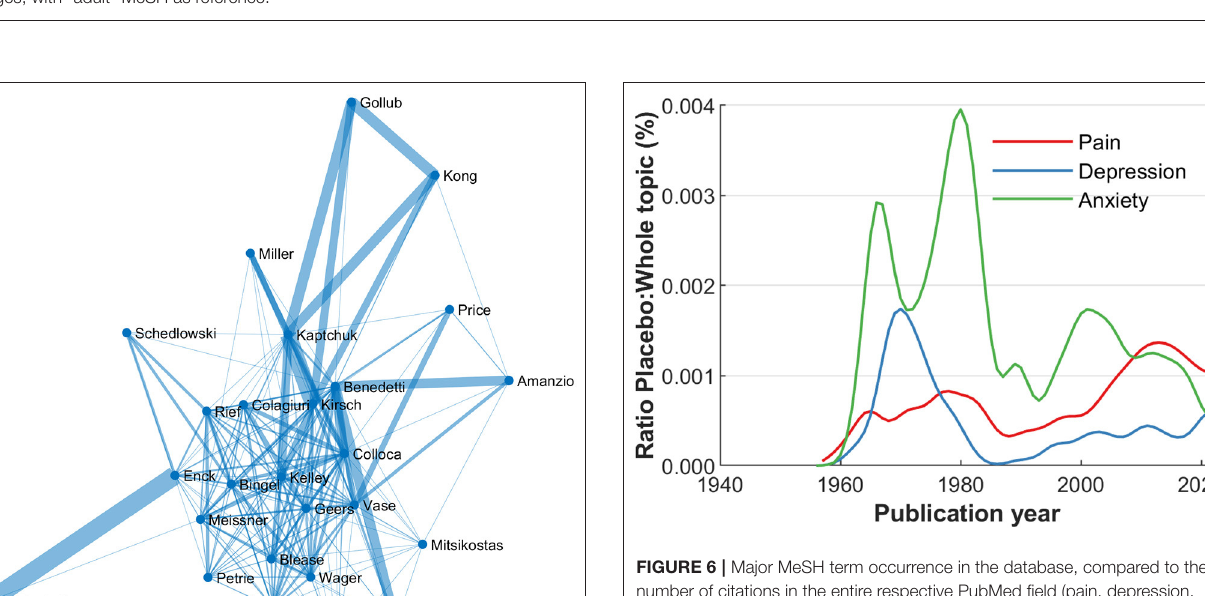
FIGURE 4 | Comparative frequency of articles by MeSH terms: Related to the investigated population. (A) Younger ages, with “adult” MeSH as reference. (B) Older ages, with “adult” MeSH as reference.